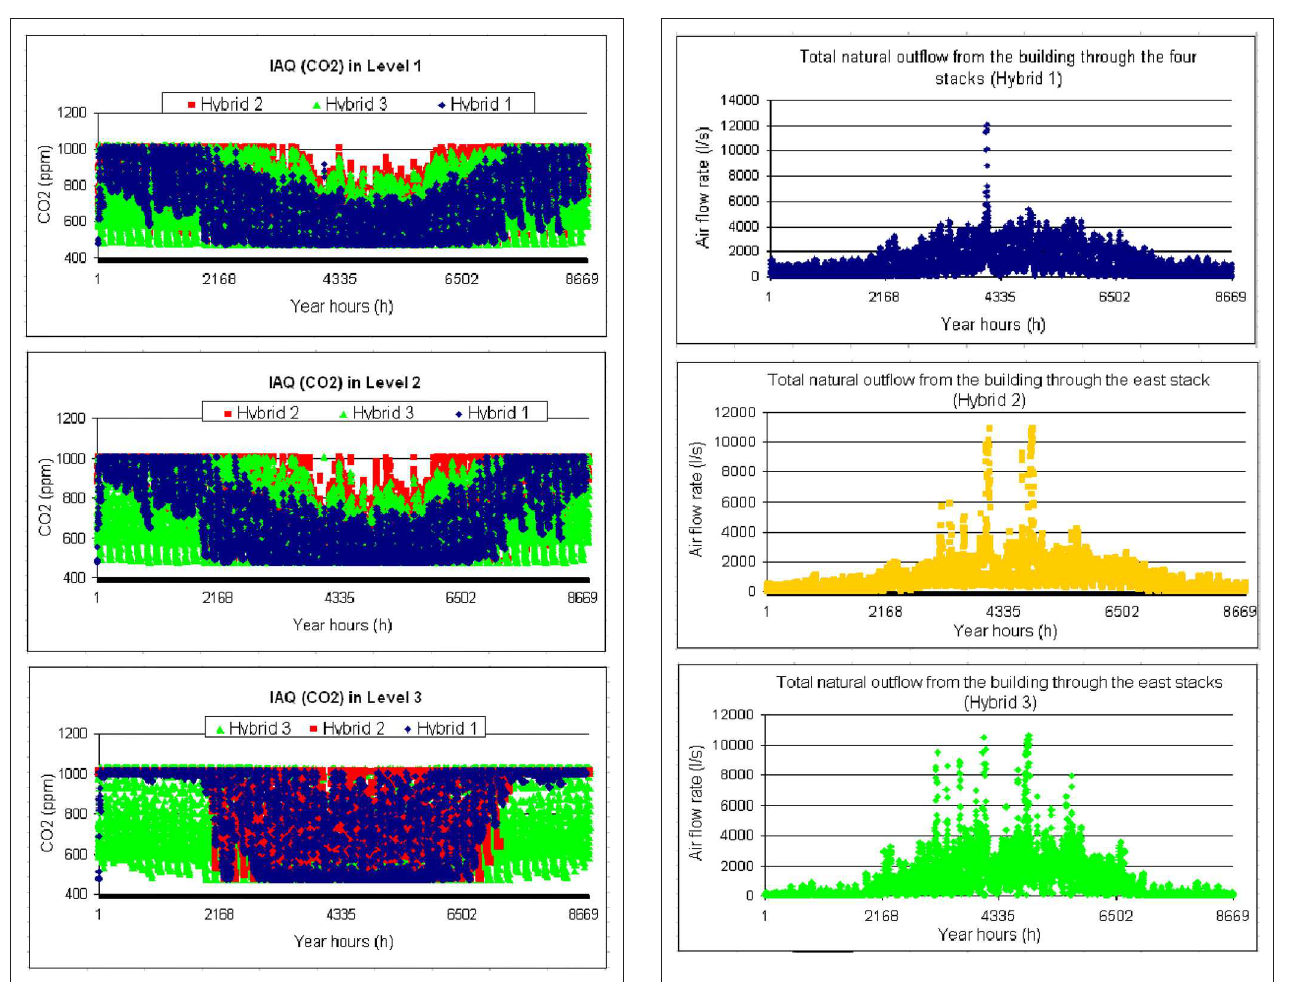
3) are suggested and compared vs. a traditional mechanical ventilation system. Different criteria related to comfort,